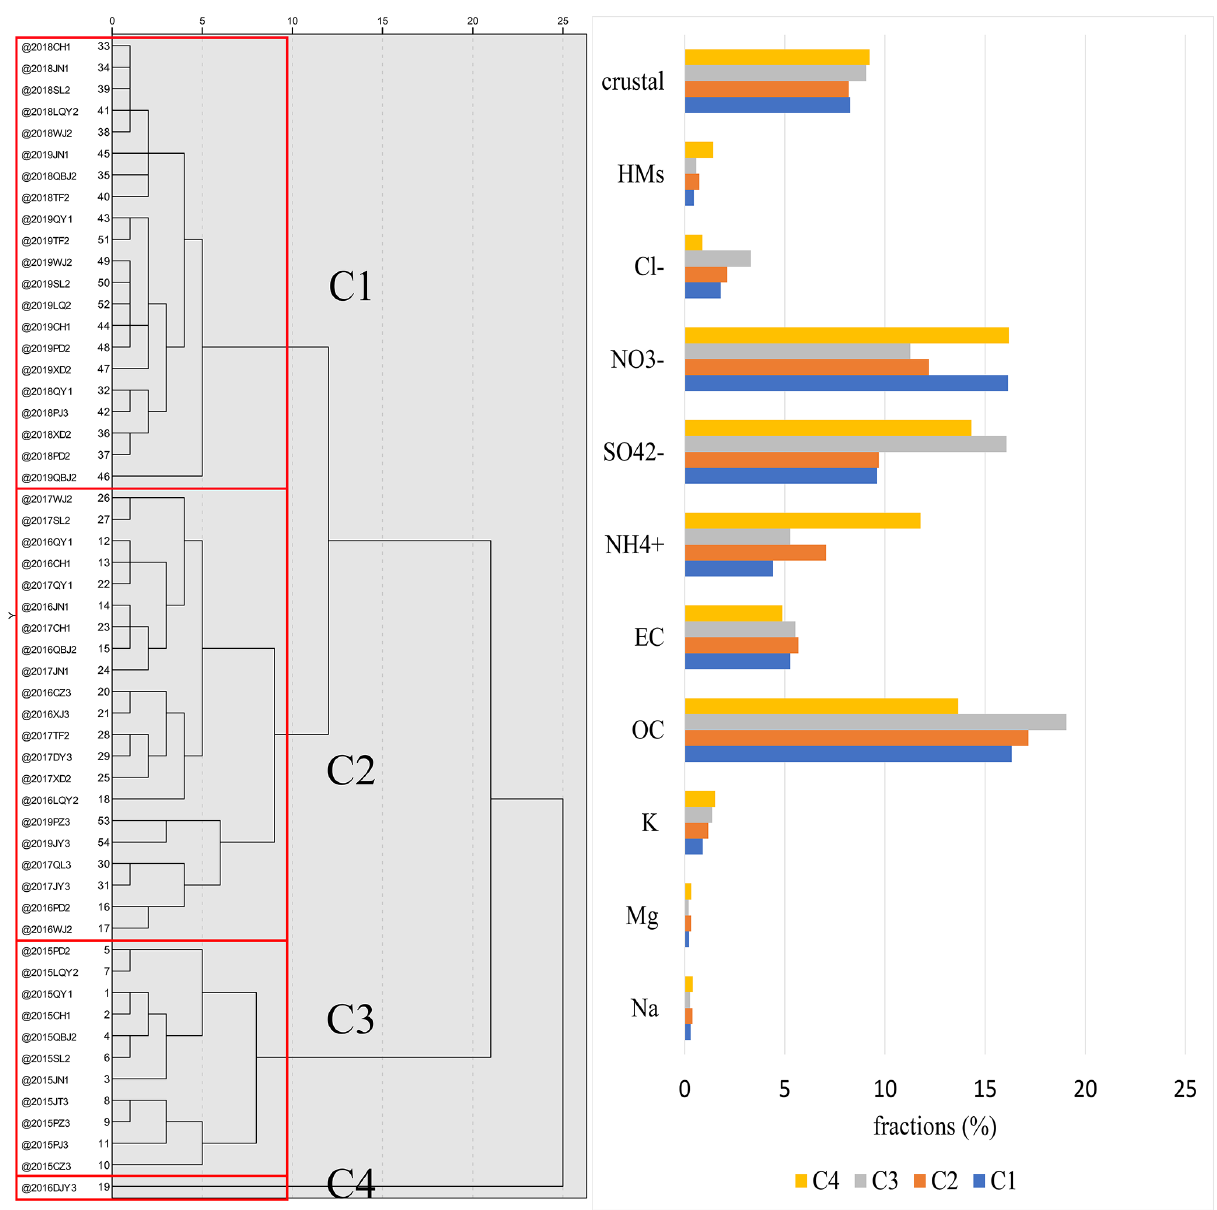
Figure 4. The HCA results (based on cosine distances) of chemical species (%) at sampling sites for 5 years (2015–2019) and their averaged species